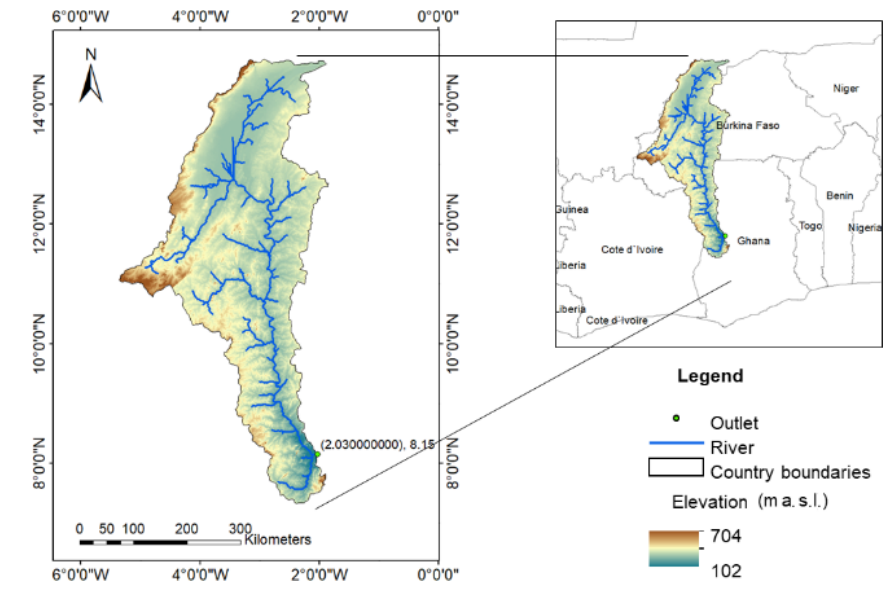
Figure 1. Location of the Bamboi